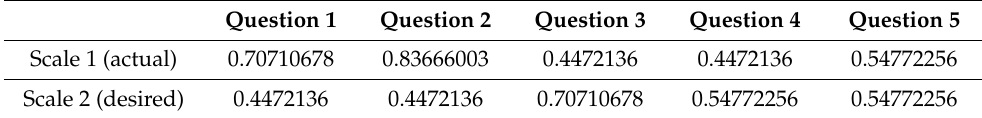
Table 3. Standard deviations for the Likert scales from each question.